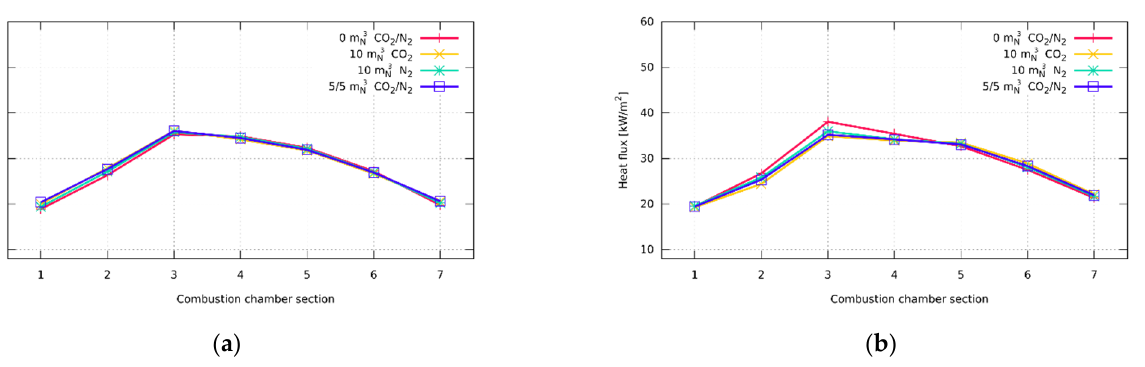
Figure 11. Influence of inert gas addition on heat flux distribution—burner with staged fuel distribution—Burner A: ( a ) primary regime; ( b ) secondary regime.